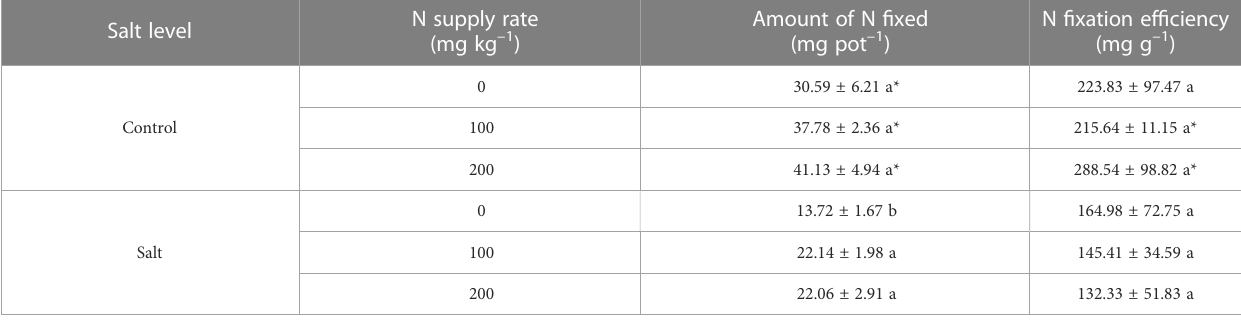
TABLE 2 Amount of nitrogen (N) fi xed and N fi xation ef fi ciency of nodules in different N supply rates and salt levels in experiment